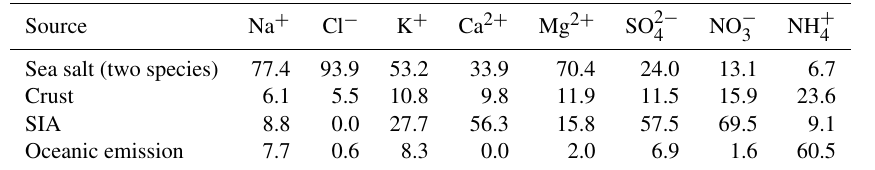
Table 4. Relative contributions (%) for different major ions from potential five sources of TSPs at Yongxing Island over the year, based on PMF 5.0 model.